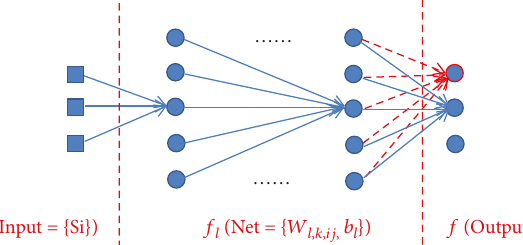
Figure 4: Changing of neural network target vector set.